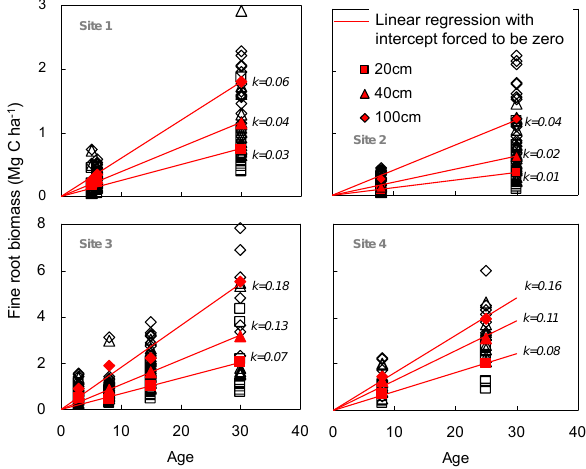
Fig. 5. The changes of mean fine roots carbon biomass with plan- tation age at different soil depths. The black symbols are samples and the red symbols are means. k is the regression slope. The co- efficients of determination of the linear regressions are R 2 ≥ 0.96 at p < 0.05. Figures are not shown for sites 5 and 6 due to missing